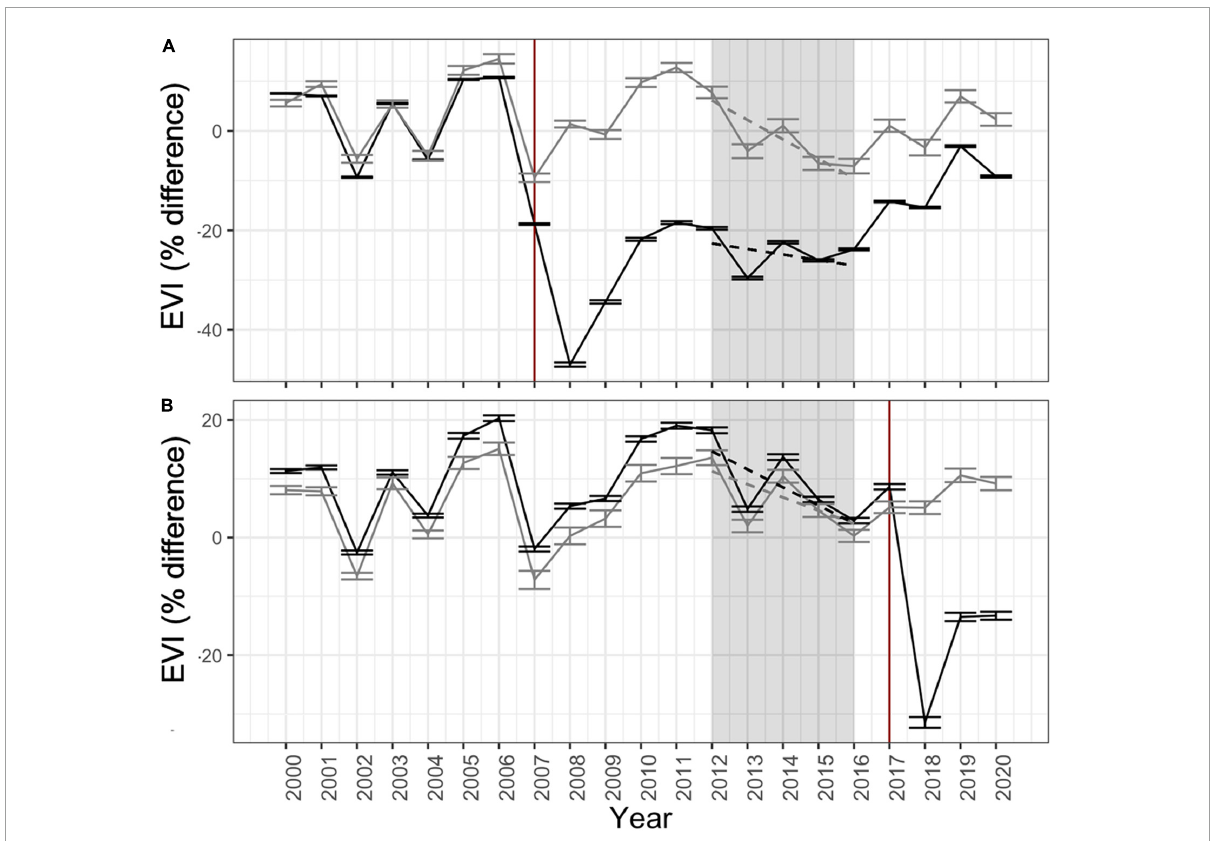
FIGURE5 Timeseries of Landsat-derived vegetation condition (EVI) each year from 2000–2020 for all burned (black lines) and unburned (gray lines) bigcone stands across the Zaca (A) and Thomas Fire (B) areas. EVI values are % difference from historical conditions (1984–2000). Shaded regions represent period of exceptional multi-year drought that began in 2012 and ended in 2016. Vertical red lines represent the year of the fire. Dashed lines indicate the trend of vegetation condition during the historic drought period, used as an index of drought response. Error bars are ±